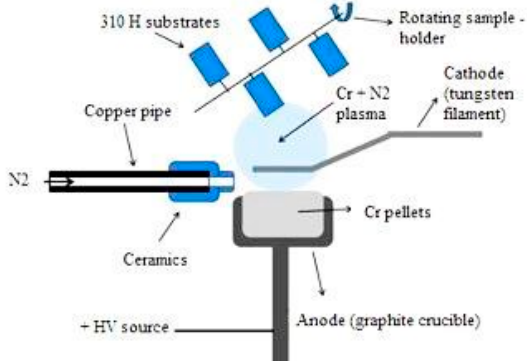
Figure 1. Experimental setup for TVA coating technique used to develop a CrN x thin film on the 310 H SS surface. 310 H SS